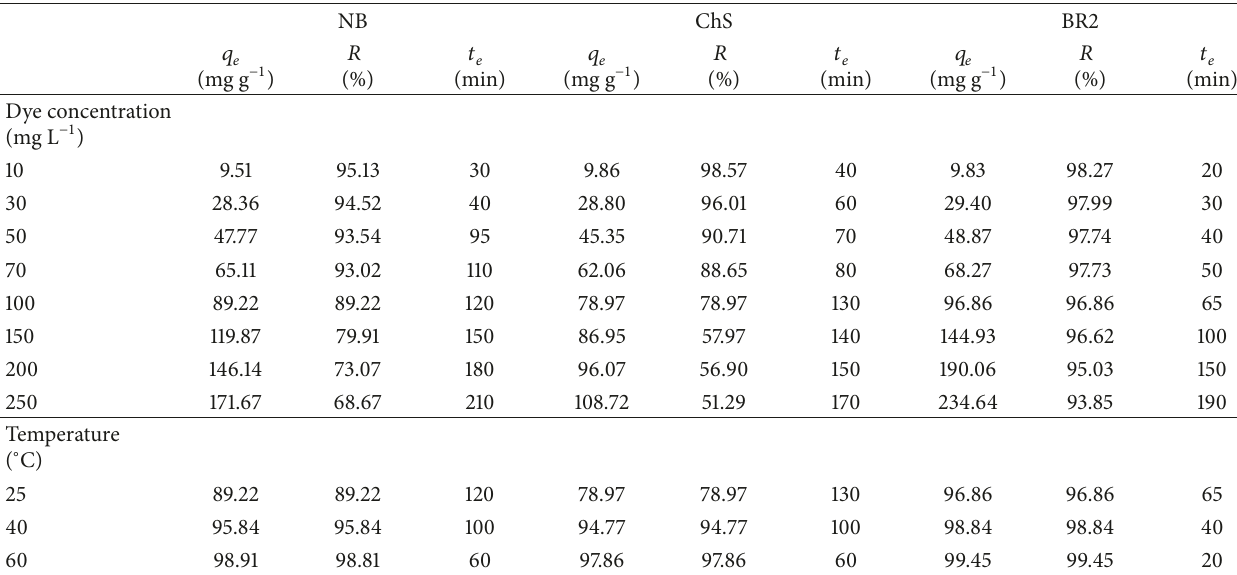
Table 3: Influence of the process variables on the adsorption process.